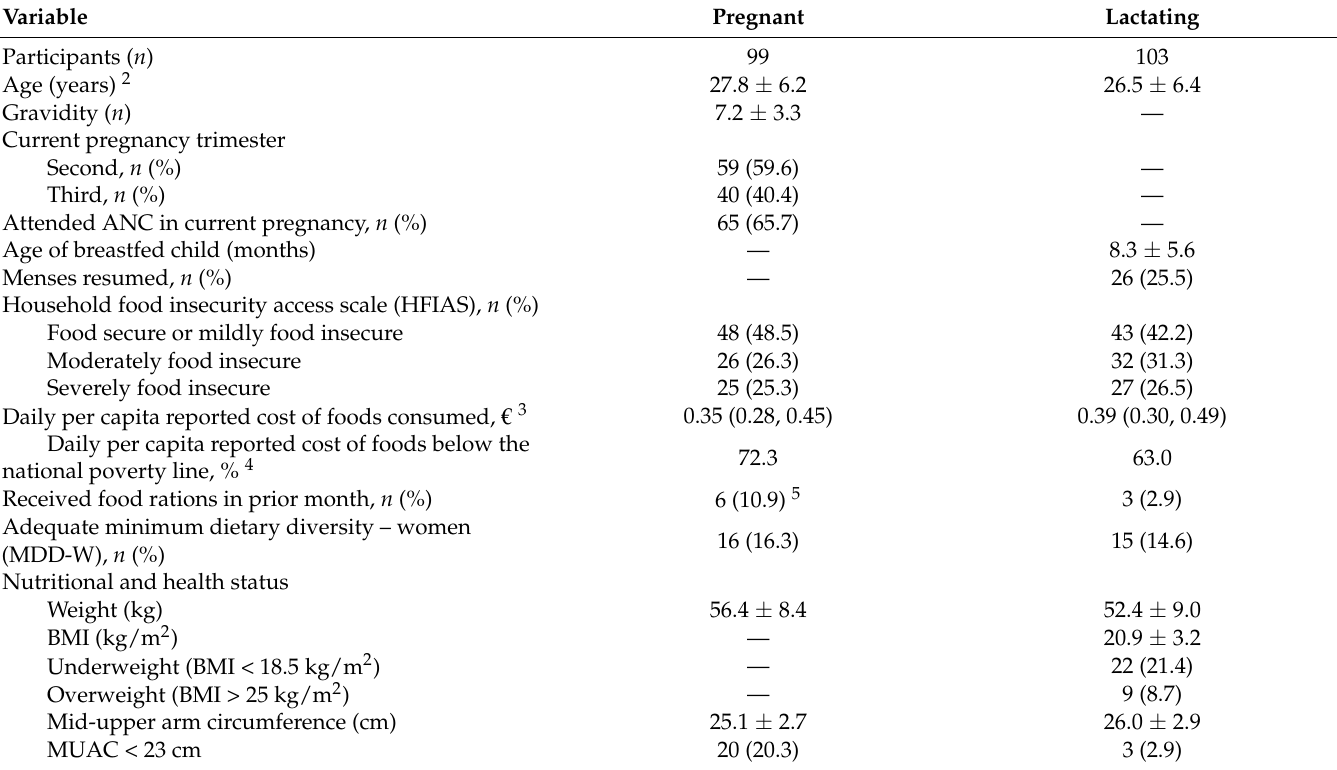
Table 2. Demographic characteristics of pregnant and lactating women and their households 1